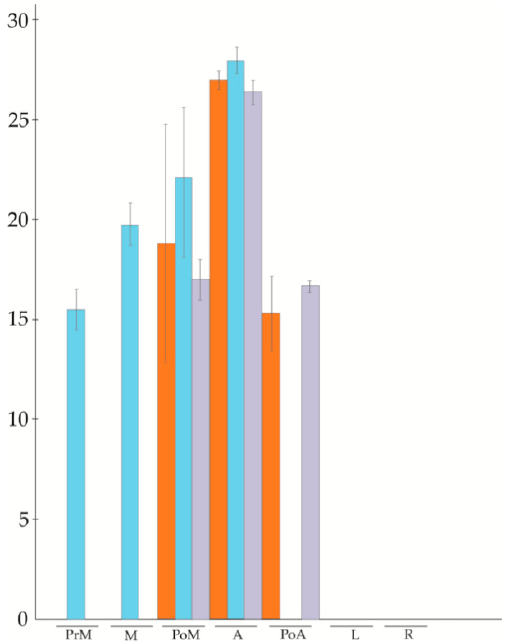
Figure 2. qPCR profile of APOSTART_6 member in three different sets of genotypes (orange, apomictic genotypes; blue, sexual genotypes; purple, parthenogenetic recombinant genotype).